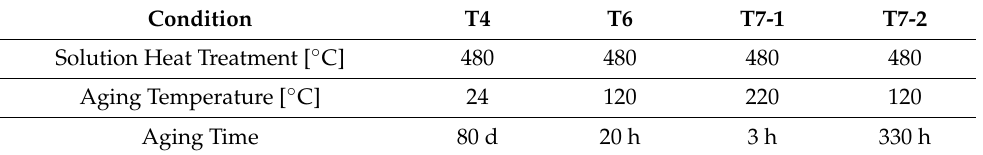
Table 2. Heat treatment parameters for different conditions of AA7075 .